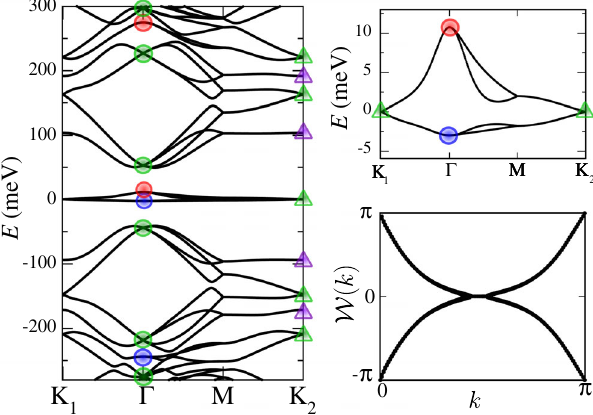
FIG. 2. (a) Electronic band structure of twisted bilayer gra- phene at the angle θ ¼ 1 . 08 after full atomic relaxation. The charge neutrality point is the zero of energy. The irreps at the Γ point are encoded by colored circles, where blue, red, and green stand for the A 1 þ B 1 , A 2 þ B 2 , and E 1 þ E 2 irreps of the D 6 space group, respectively. At the K 2 point the E and A 1 þ A 2 irreps of the little group D 3 are represented by green and violet triangles, respectively. (b) Enlargement of the FBs region. (c) Wilson loop of the four FBs as function of k ¼ G 2 = π